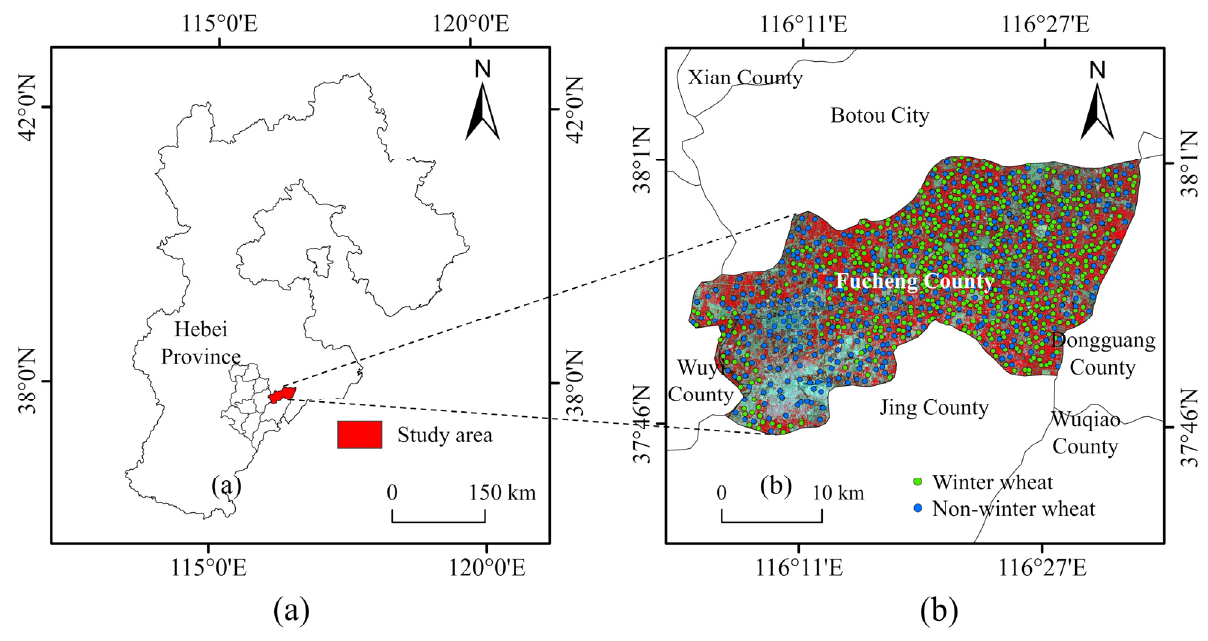
Figure 1. ( a ) Location of the study area, ( b ) the spatial distribution of sample